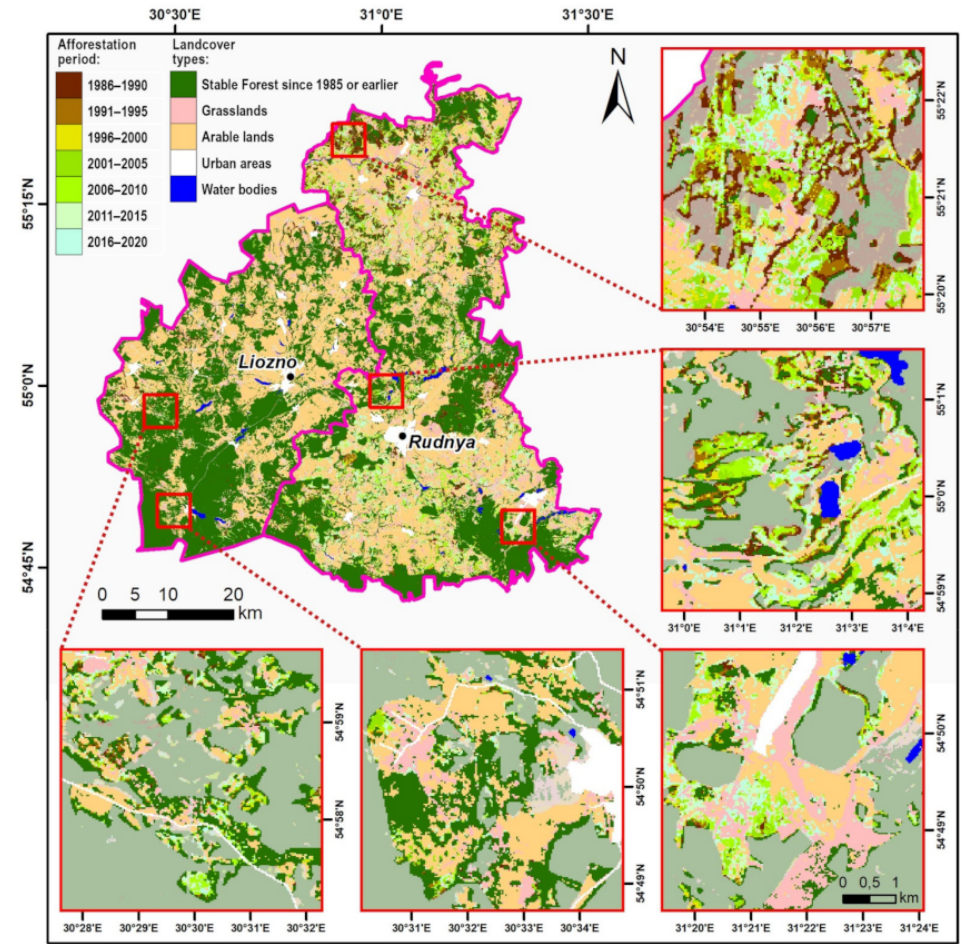
Figure 9. Afforestation dynamics over the study area. Territories outside the IAL are lightened with semi-transparent overlay on the insert